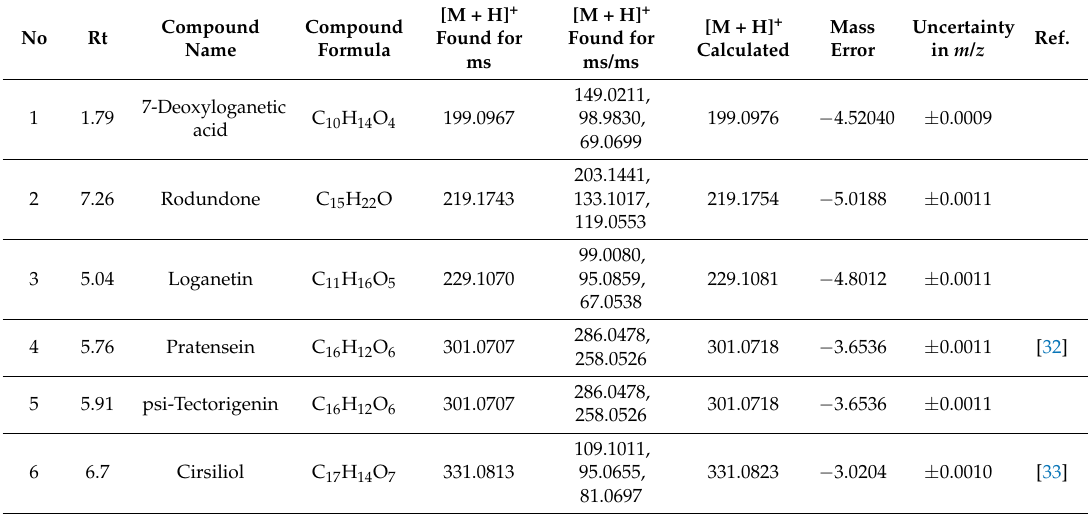
Table 4. LC-MS/MS analysis ethyl acetate crude extracts of A. lagopoides